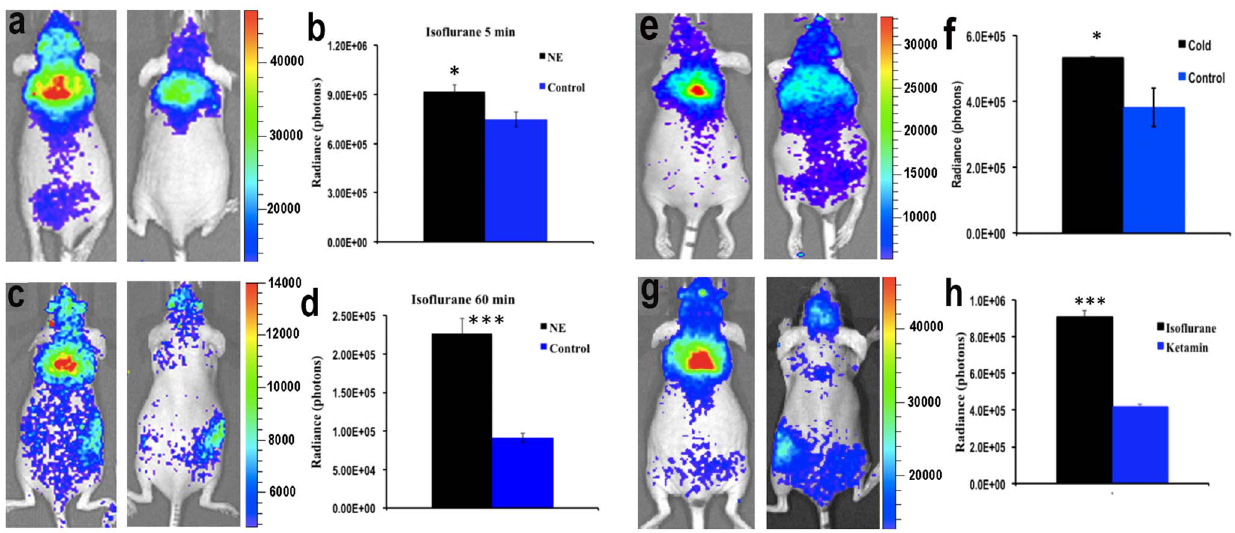
Figure 4. CLI imaging with 18 F-FDG for monitoring BAT activation. (a) Representative CLI images of BAT of mice with (left) and without (right) NE stimulation under short isoflurane anesthesia. (b) Quantitative analysis of the CLI signals from the two groups in a (n=4 for each group). (c) Representative CLI images of BAT of mice with (left) and without (right) NE treatment under long isoflurane anesthesia (60 minutes). (d) Quantitative analysis of the CLI signals from the two groups shown in c (n=3–4 for each group). (e) Representative CLI images of BAT of mice with (left) and without (right) cold stimulation under short isoflurane anesthesia. (f) Quantitative analysis of the CLI signals from the two groups shown in e (n=3–4 for each group). (g) Representative CLI images of BAT at 60 minutes after 18 F-FDG injection under short isoflurane anesthesia (5 min) (left) and ketamine/xylazine anesthesia (70 minutes) (right). (h) Quantitative analysis of the CLI signals from the two groups shown in g (n=4 for each group).